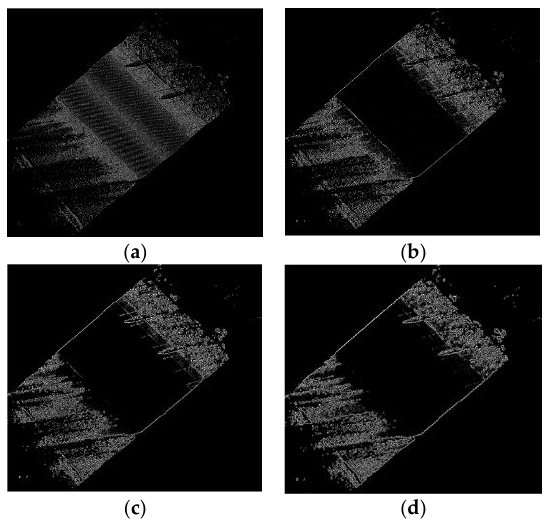
Figure 13. Different elevation-gradient images with different grid sizes: ( a ) GSD = 0.03 m; ( b ) GSD = 0.06 m; ( c ) GSD = 0.09 m; and ( d ) GSD = 0.12